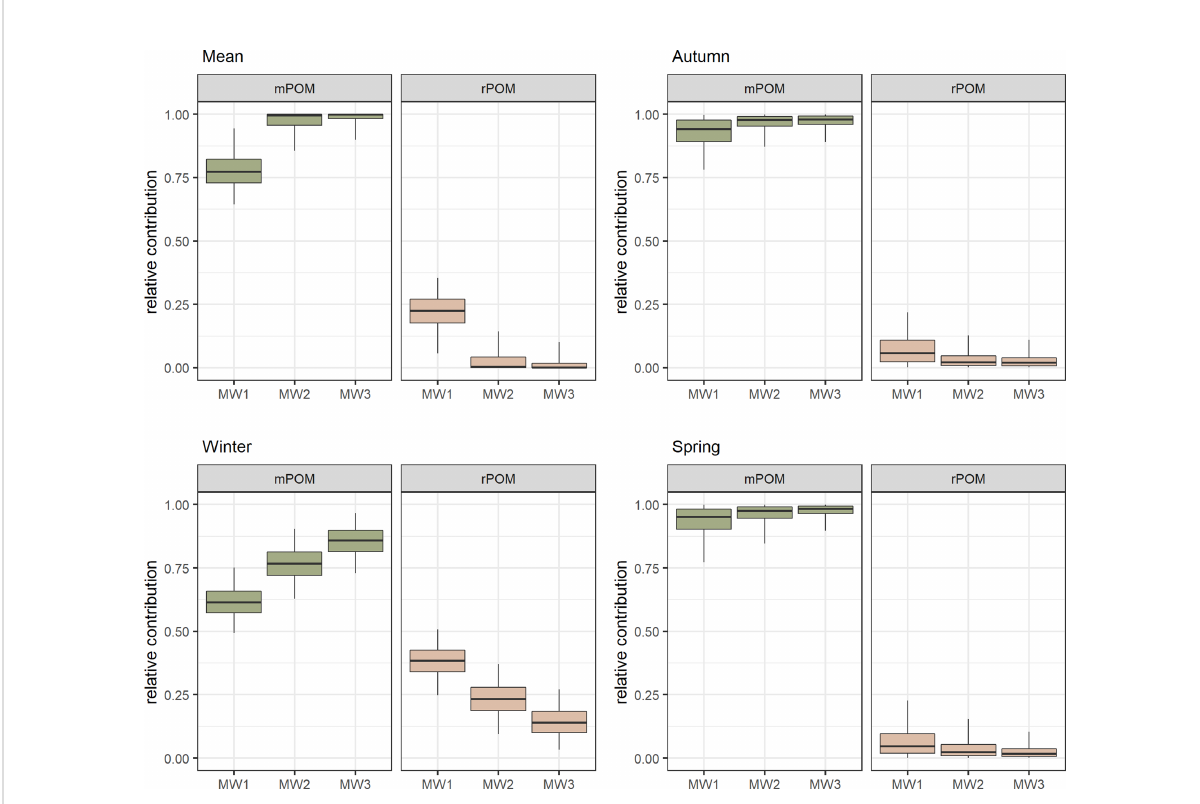
FIGURE 3 The probability distribution of relative contribution [%] of mPOM (collected at the open coast of western Poland) and rPOM (collected ~12 km upstream in the Vistula River) to the pPOM (prodelta POM, collected at sampling stations). Boxplots depict median (horizontal line) with 50% (box) and 95% credible intervals (vertical